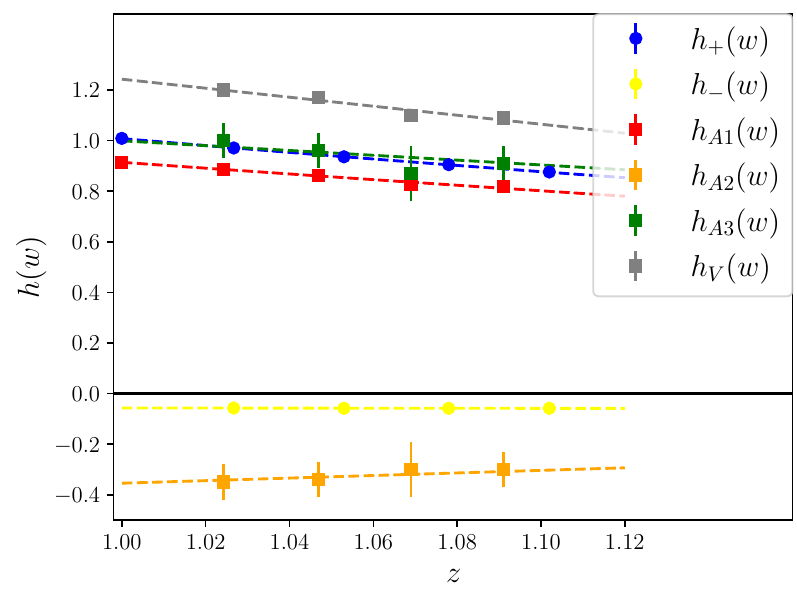
Figure 27 . Form factors computed from three-point